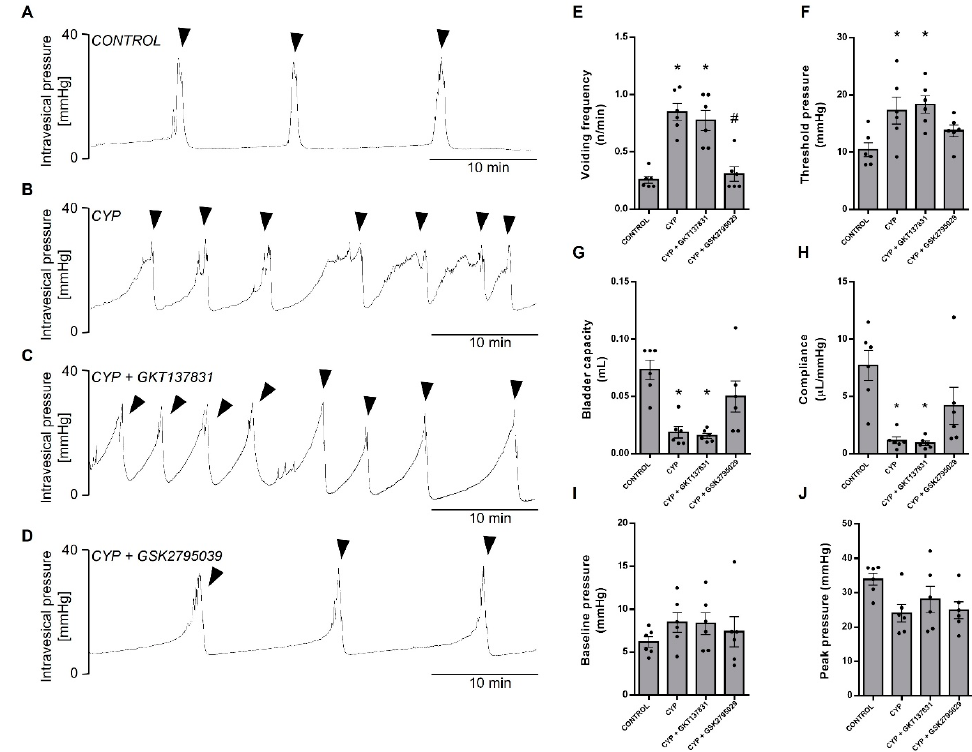
Figure 5. Cystometry under urethane anesthesia and continuous saline filling (0.6 mL/h). Representative cystometric tracings ( A – D ) of the control (saline) and cyclophosphamide (CYP, 300 mg/Kg, ip, 24 h)-injected animals untreated or treated (three doses in 24 h) with the NOX1/4 inhibitor GKT137831 (5 mg/Kg, ip) or NOX2 inhibitor GSK2795039 (5 mg/Kg, ip). Changes in the cystometric parameters ( E ) basal pressure, ( F ) threshold pressure to initiate voiding, ( G ) bladder capacity, ( H ) compliance during the filling phase, ( I ) peak pressure, and ( J ) voiding frequency. Summary data (mean ± SEM) represent n = 6 for all of the groups. Significance was tested by two-way ANOVA followed by multiple comparisons by Tukey’s post-hoc test. * p < 0.05 vs. CONTROL; # p < 0.05 vs. CYP. Arrowheads indicates voidings. One mouse was used for each cystometrogram.